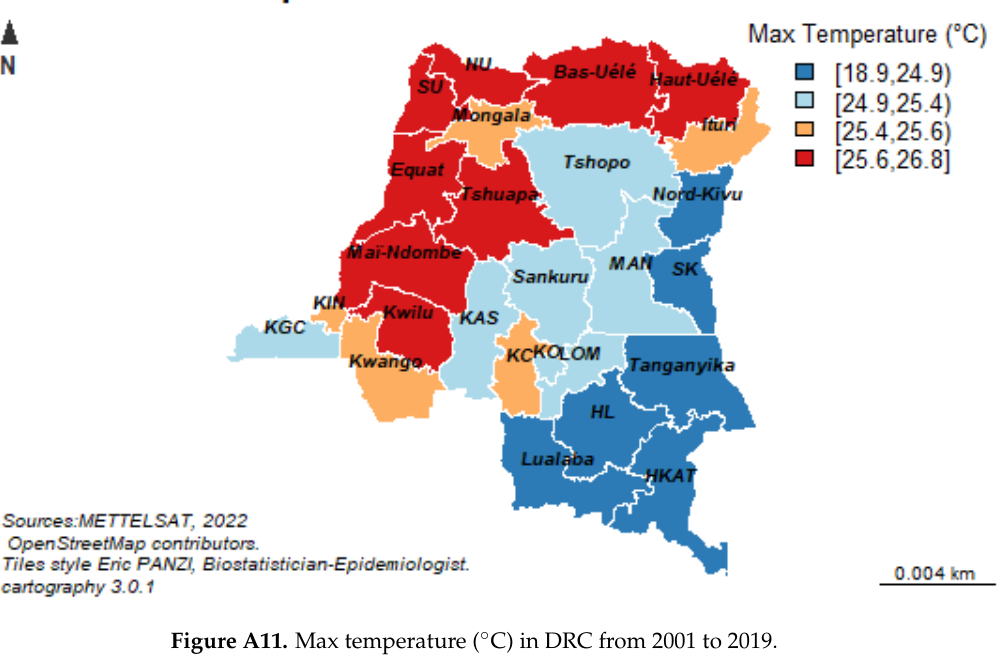
Figure A11. Max temperature (°C) in DRC from 2001 to 2019.